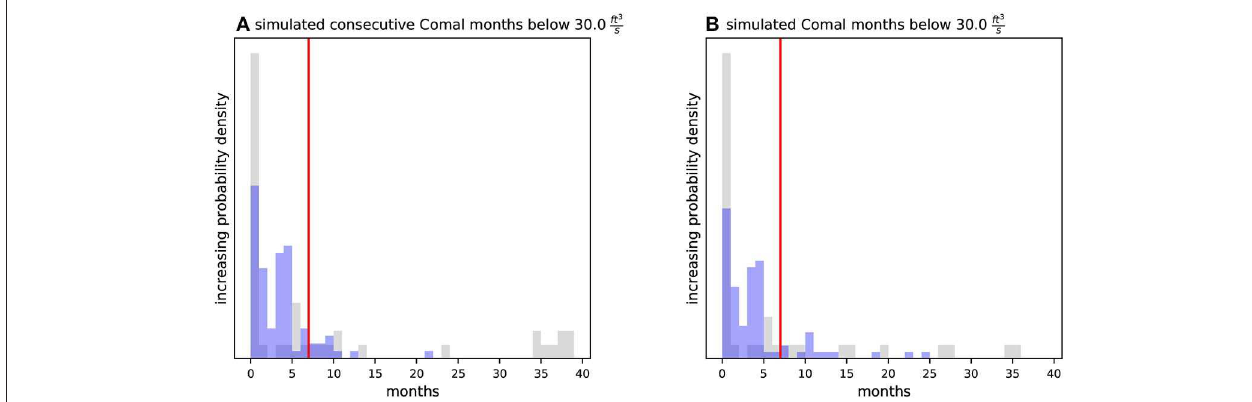
FIGURE 5 | Prior (gray) and posterior (blue) ensemble results for (A) the consecutive months below 30 ft 3 during the scenario simulation. The red vertical line marks the observed values (7 months for both). The PE analyses has reduced the number of extreme cases and has moved the ensemble closer to the observed values, however, considerable uncertainty remains. Note the X-axis scale was selected to focus on the posterior realizations; 37 prior realizations yielded greater than 40 consecutive months below 30 ft 3 these prior realizations are not